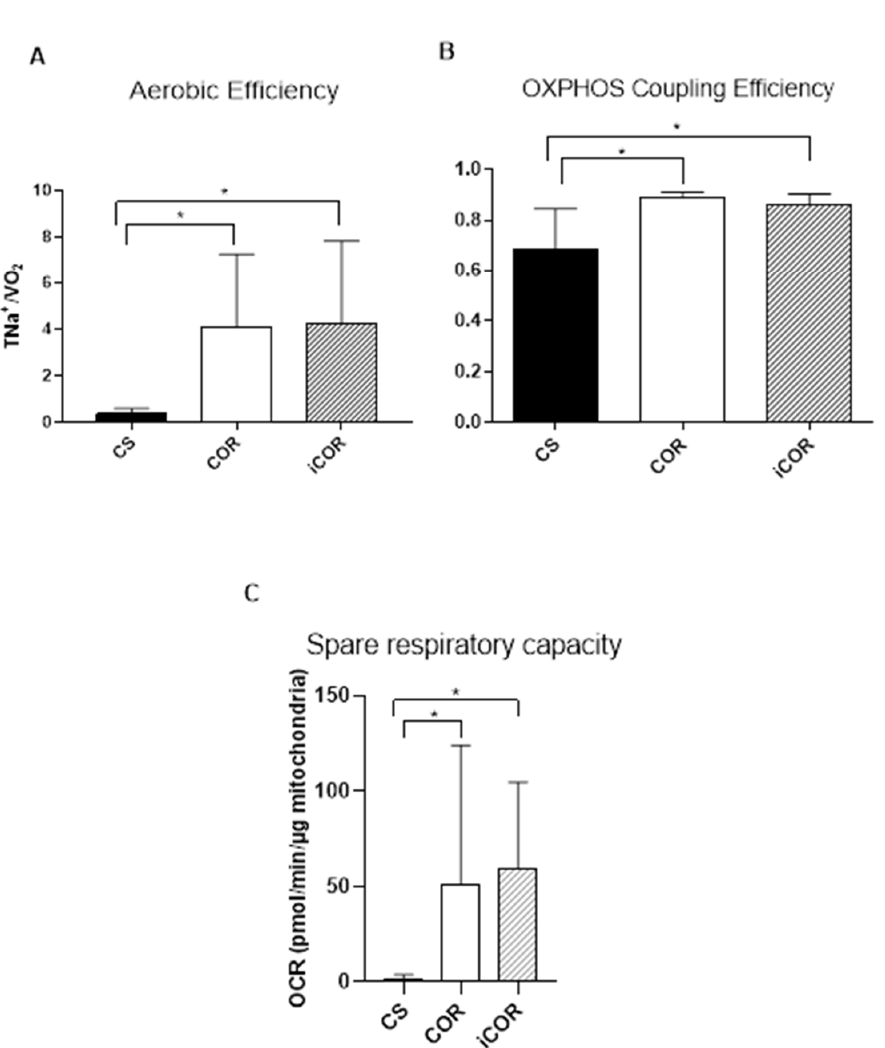
Figure 4. Parameters of mitochondrial function upon isolated reperfusion in vitro after 20 h cold storage (CS) or after 2 h of subsequent controlled oxygenated rewarming with (COR) or without (iCOR) an initial hypothermic perfusion period: ( A ) renal aerobic efficiency reflected by the ratio of total tubular sodium transport (TNa) and oxygen consumption (VO2); ( B ) OXPHOS coupling efficiency and ( C ) spare respiratory capacity of isolated mitochondria at the end of the 90 min reperfusion period (*: p < 0.05 vs. CS).